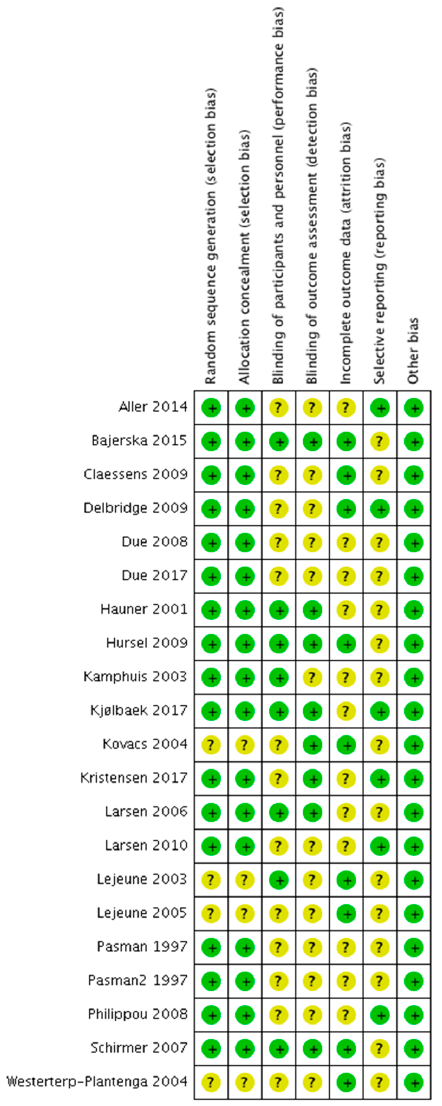
Figure 2. Risk of bias analysis of the individual studies included in the systematic review and meta-analysis. Green dot = low risk of bias; yellow dot = unclear risk of bias.